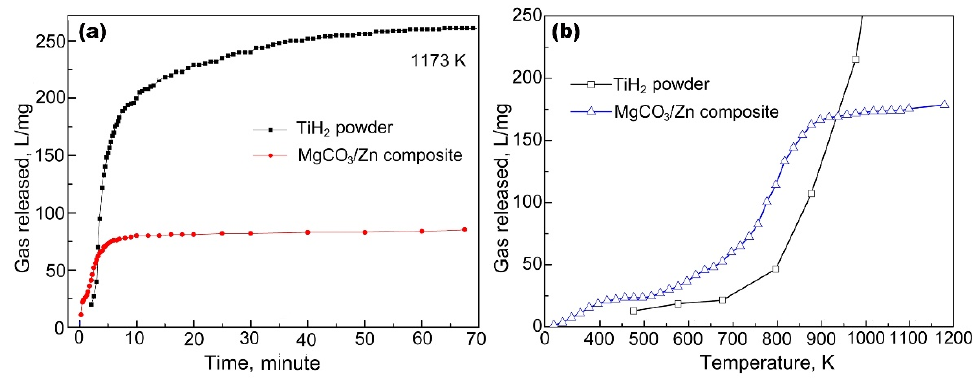
Figure 2. The decomposition of the MgCO 3 /Zn composite powder and TiH 2 powder under two con- ditions: ( a ) constant temperature heating and ( b ) continuous temperature heating.